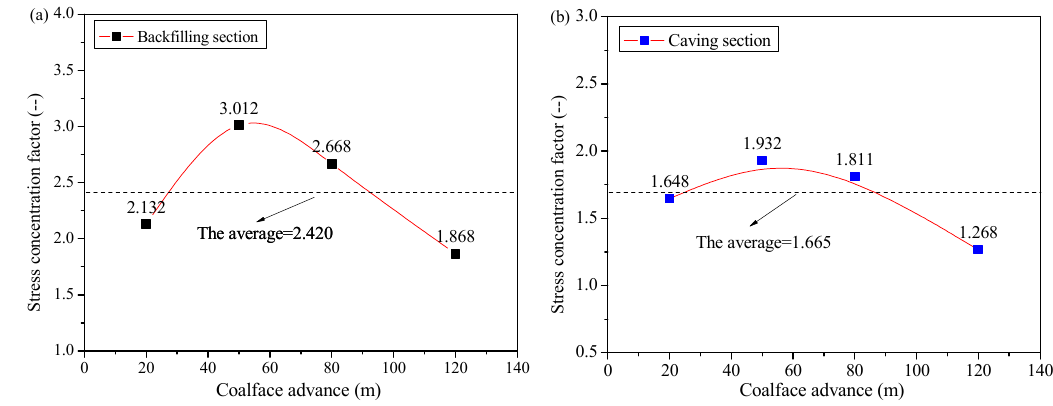
Figure 10. Stress concentration factor of the front abutment pressure: ( a ) backfilling section; ( b ) caving section.